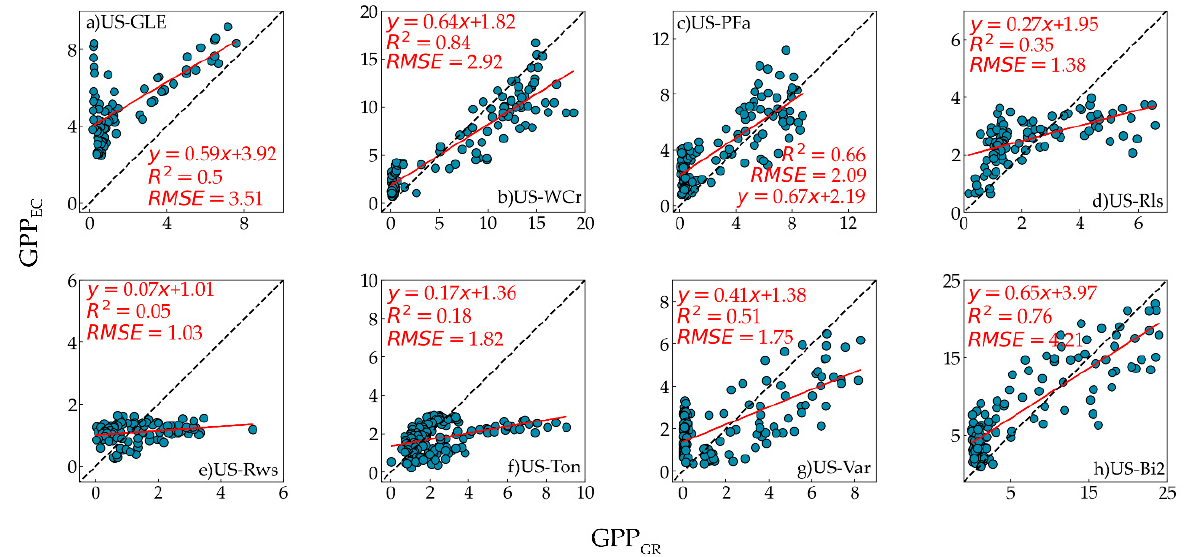
Figure 5. Scatter plots between GPP GR and GPP EC for all sites in 2017–2018. ( a – h ) represent the site the same as Figure 4.